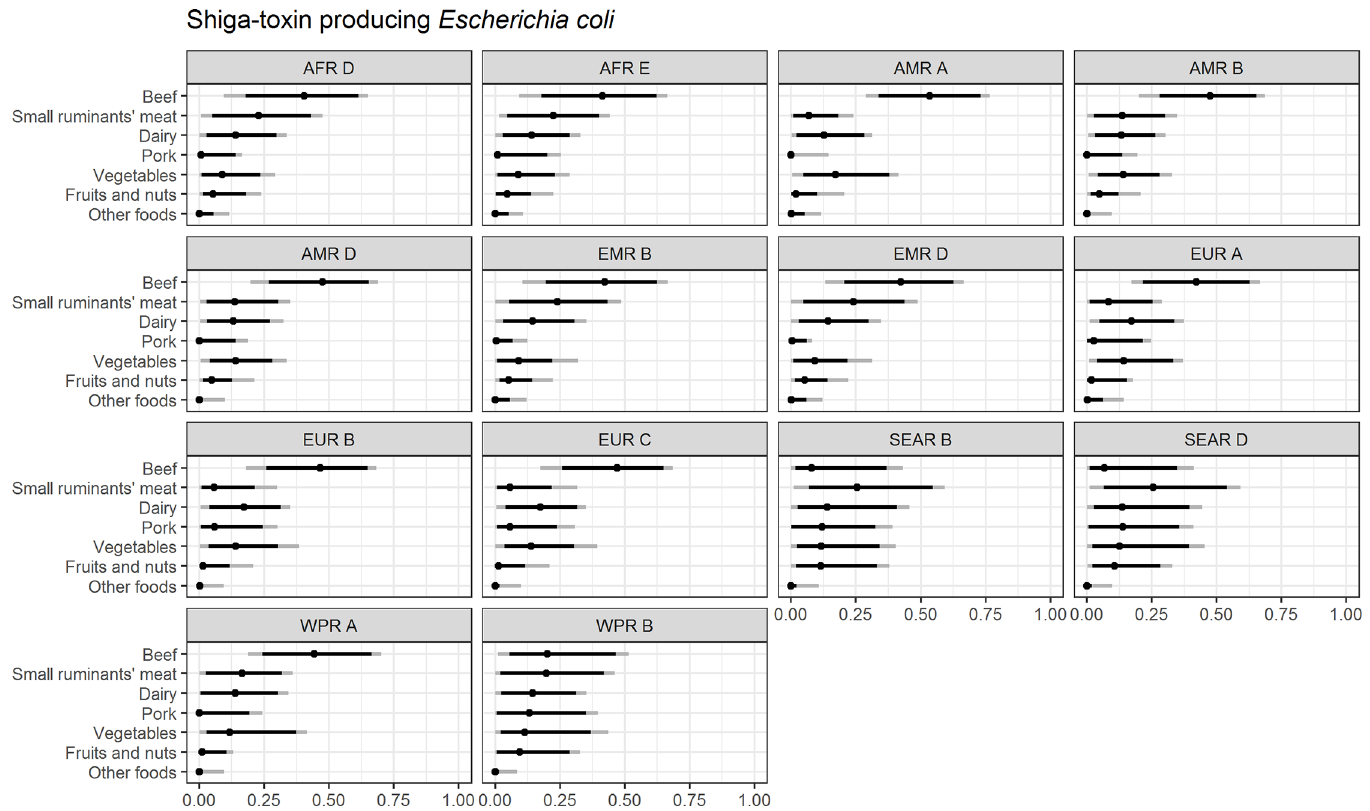
Fig 14. Shiga-toxin producing Escherichia coli (STEC). Proportion of foodborne disease attributable to specific foods: Median estimate, and 90% and 95% uncertainty intervals by bacteria and subregion. “Small ruminants’ meat” was listed as “Goat, lamb and other small ruminants’ meat” in the expert elicitation instrument. The X-axis labels are percentages. The dot represents the median estimate; the dark black line, the 90% uncertainty interval; and the gray line the 95% uncertaintyinterval.